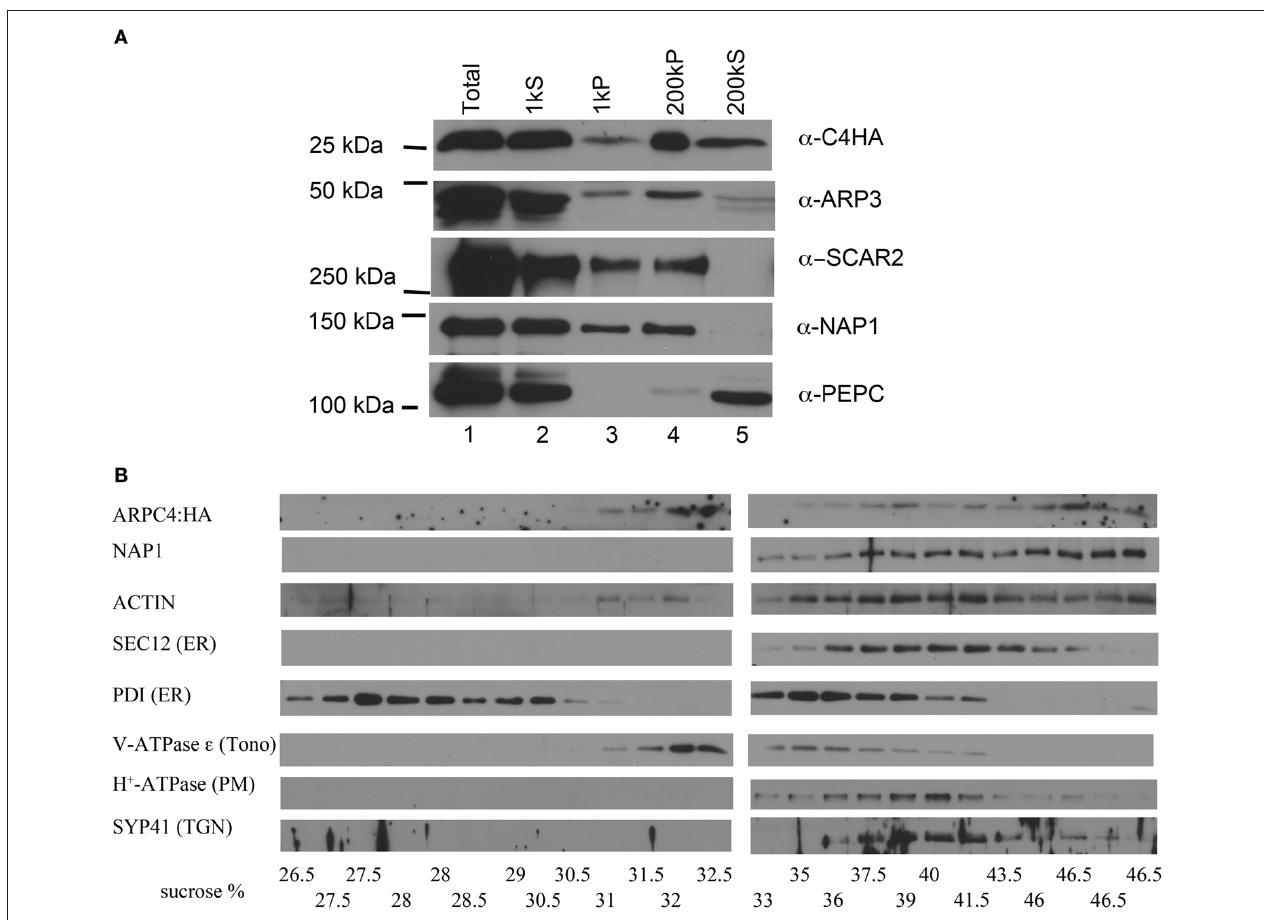
FIGURE 1 | ARP2/3 specifically associates with distinct organelles. (A) Differential centrifugation of leaf cytosol and membrane fractions. Total extract was sequentially centrifuged at 1000 and 200,000g. Equal cellular proportions of each fraction were separated on SDS-PAGE gels and probed with antibodies as indicated in the figure. (B) Sucrose velocity gradient fractions of crude microsomes probed in western blots